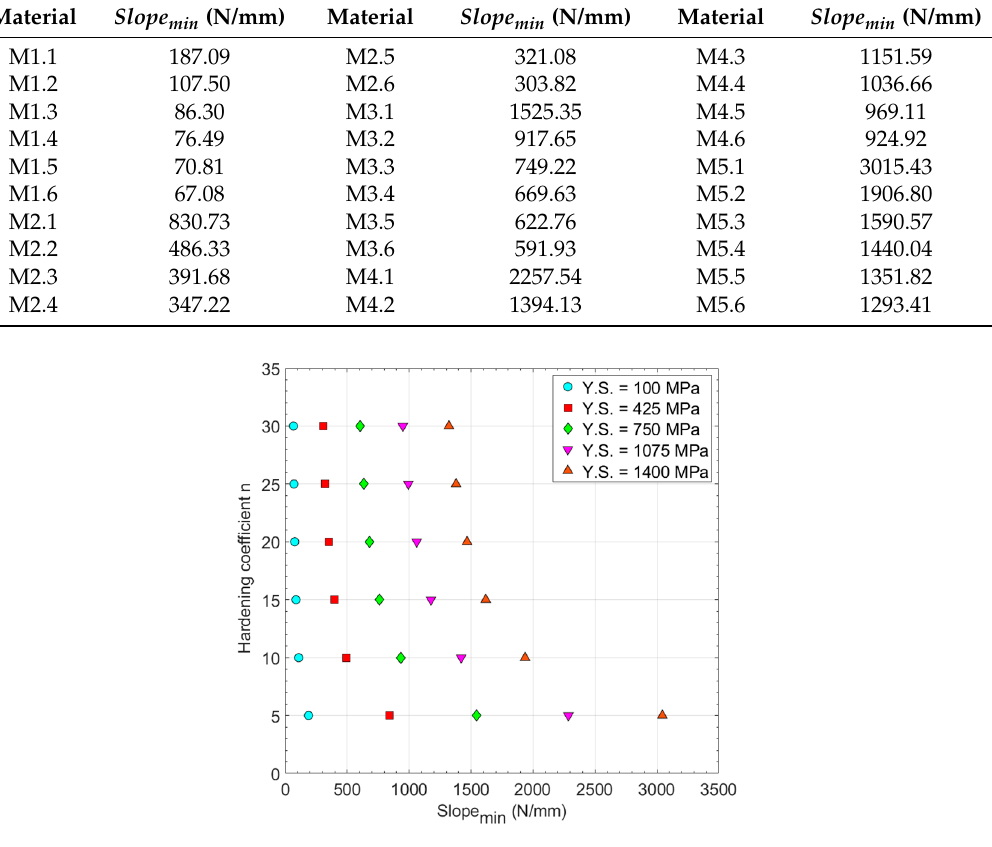
Figure 10. Hardening coefficient n vs. Slope min (Y.S.: yield strength).